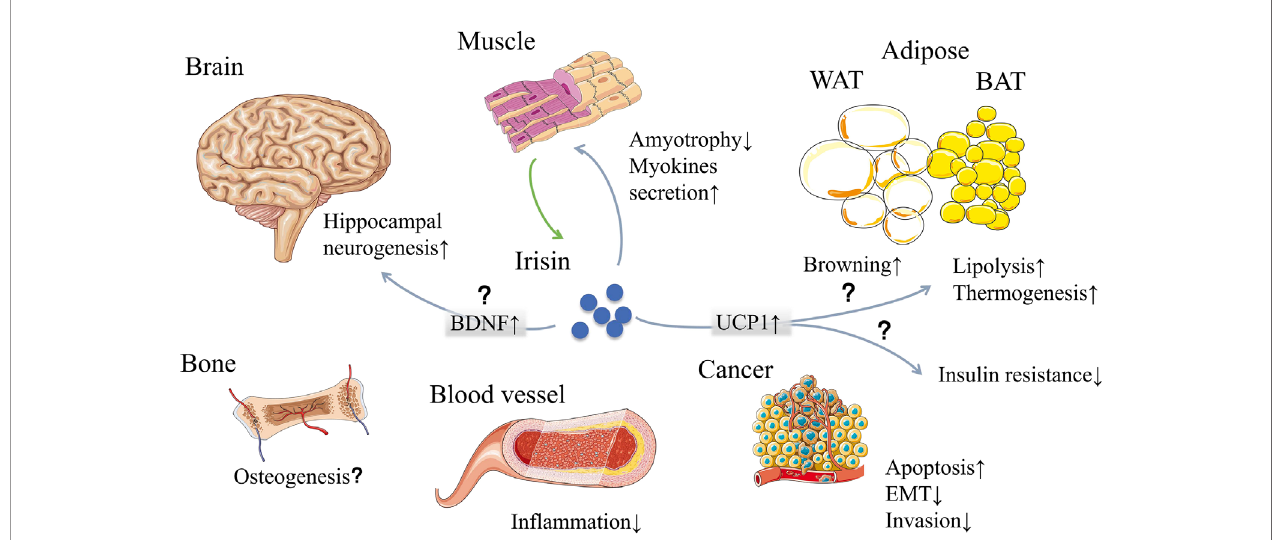
FIGURE 1 | Irisin, mainly secreted by muscle, may have effects on multiple organs and tissues. The classic functions of irisin are browning white adipose tissue and generating heat. Other effects include muscle feedback, neurogenesis, osteogenesis, in fl ammation reduction, cancer suppression and so on. However, some of the functions are now facing challenges due to the measuring problems and interspecies genetic differences. WAT, white adipose tissue; BAT, brown adipose tissue; BDNF, brain-derived neurotrophic factor; UCP1, uncoupling protein 1; EMT, epithelial-mesenchymal transition. [The elements were produced using Servier Medical Art (https://smart.servier.com/) with some